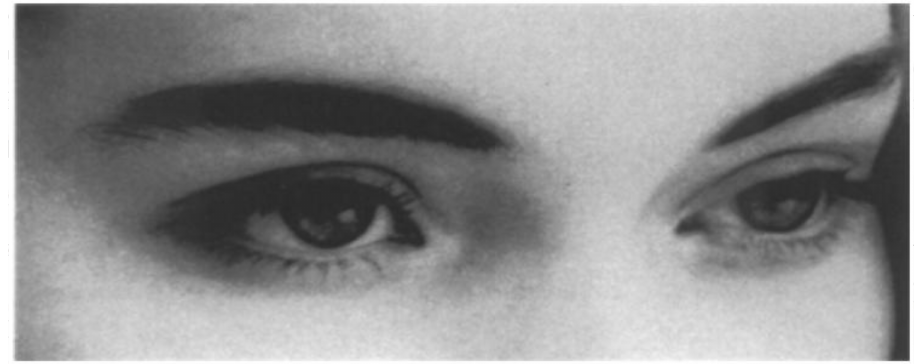
Figure 2. Mind in the Eyes Test: Example 2 (Figure 2 in